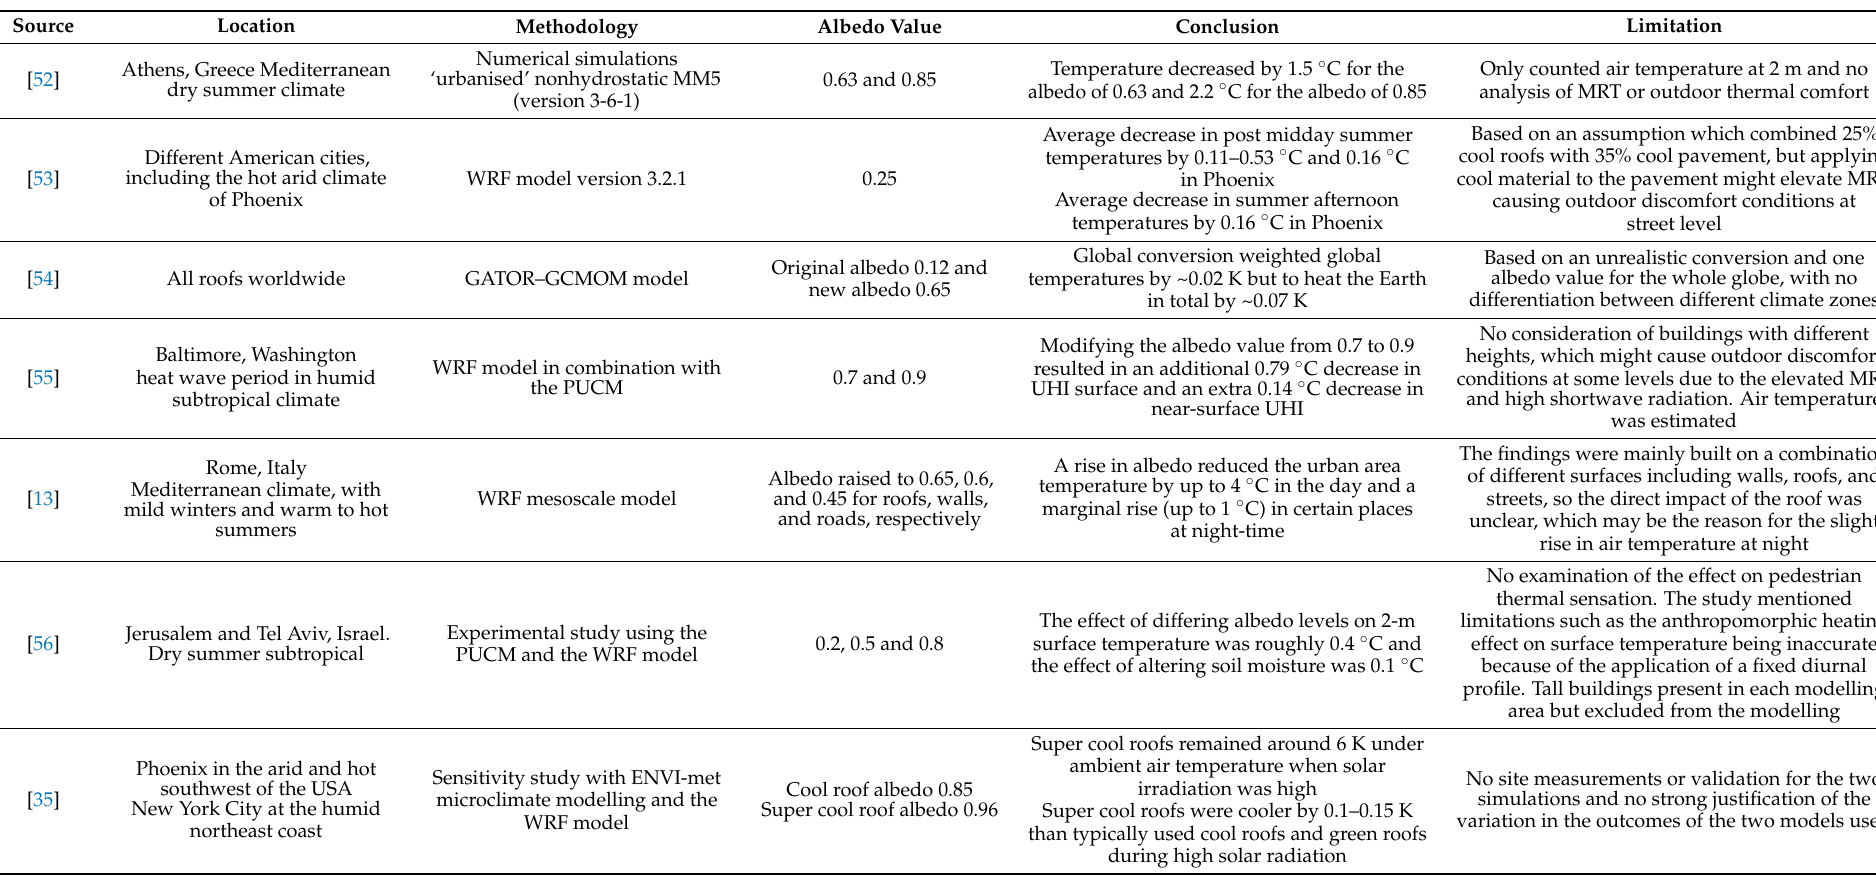
Table 1. Overview of the potential of cool roofs at the city and global scales, based on the selected